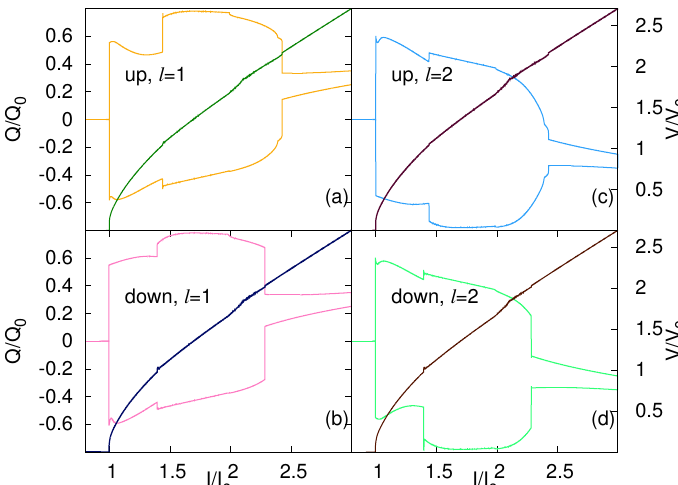
Figure 6. Maximal and minimal values of charge (light color lines) on the superconducting layers of the stack for α = 1, β = 0.9 and γ = 0.5. For the increase of current ( a ) on the 1st superconducting layer ( c ) on the 2nd superconducting layer. For the decrease of current ( b ) on the 1st superconducting layer ( l = 1), and ( d ) on the 2nd superconducting layer ( l = 2). The IV-characteristics for the corresponding direction of currents are presented with dark